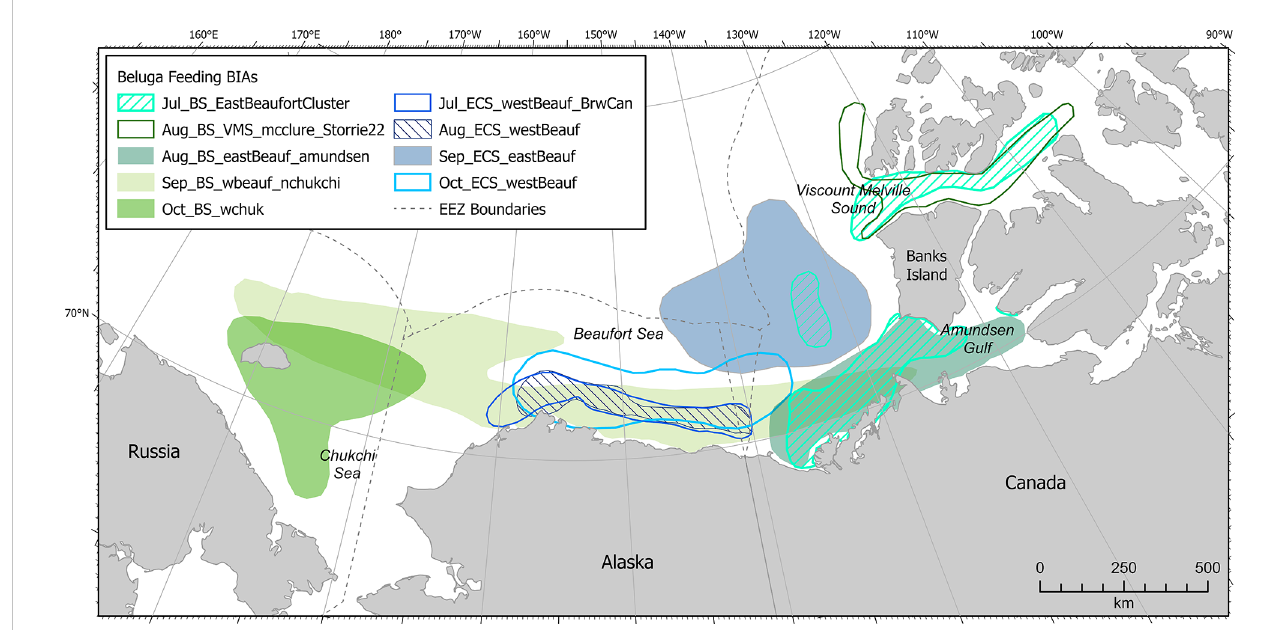
FIGURE 12 Arctic region beluga (Eastern Chukchi Sea Stock and Beaufort Sea Stock) feeding